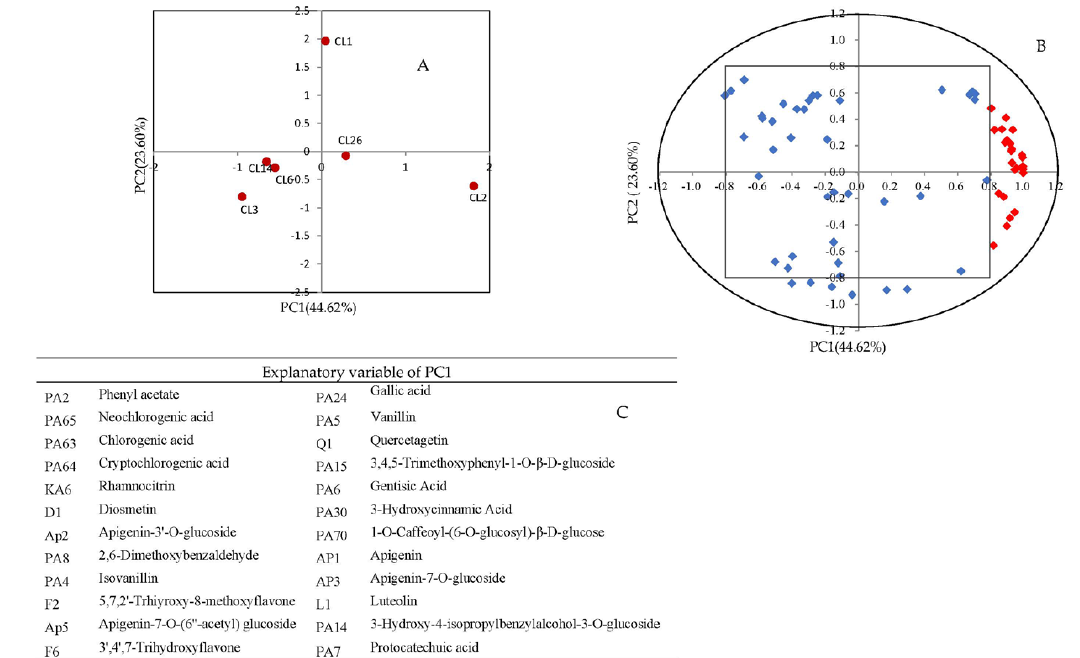
Figure 4. Principal component analysis of juice made from six celery cultivars (CL1, CL2, CL26, CL6, CL3, and CL14) using 43 phenolic acids and 23 flavonoids as variables. ( A ) Projection of cultivars; ( B ) distribution of variables; ( C ) the explanatory variables (14 phenolic acids and 10 flavonoids) of PC1 (red diamond, load value > 0.8).